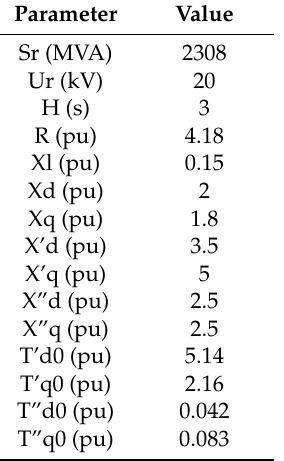
Table A7. Parameters of synchronous machine (Area 1)—subtransient model.